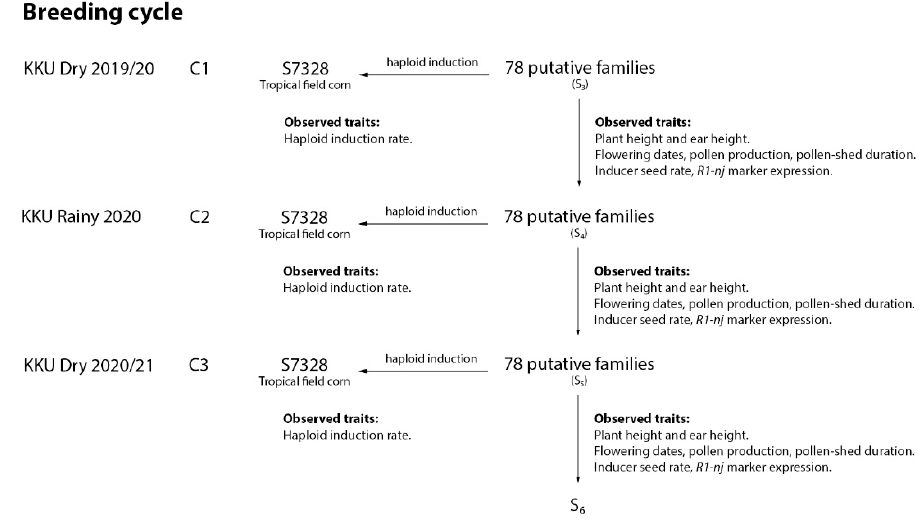
Figure 2. A two-way scheme of haploid induction (horizontal) and line purification (vertical). C1, C2, and C3 represent breeding cycle 1, cycle 2, and cycle 3, respectively.